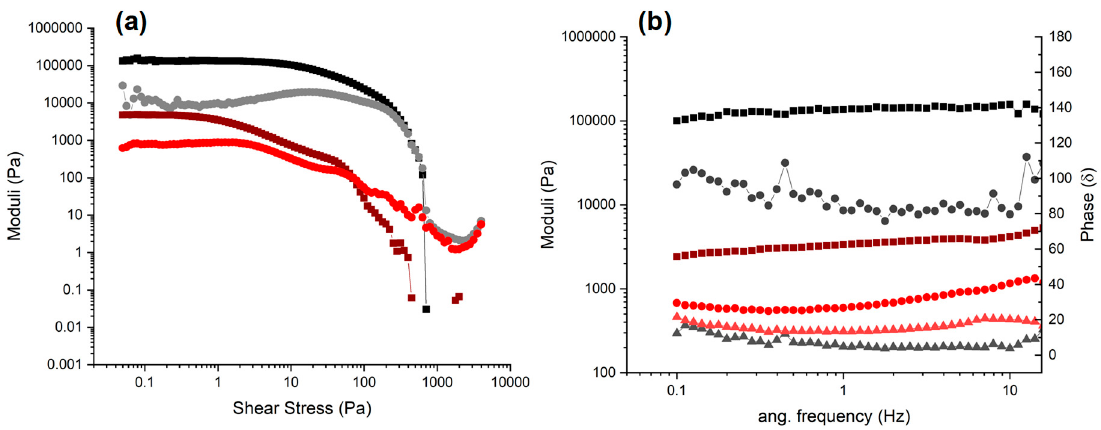
Figure 1. ( a ) Oscillatory amplitude sweeps and ( b ) oscillatory frequency sweeps, for N -(4-pyridyl)isonicotinamide ( 4PINA ) (black) and diNO (red). For both, ▪ refers to G’ and ● refers to G”, the storage modulus and viscous modulus, at 4.0 wt %, respectively. ▲ refers to the phase lag ( δ ).